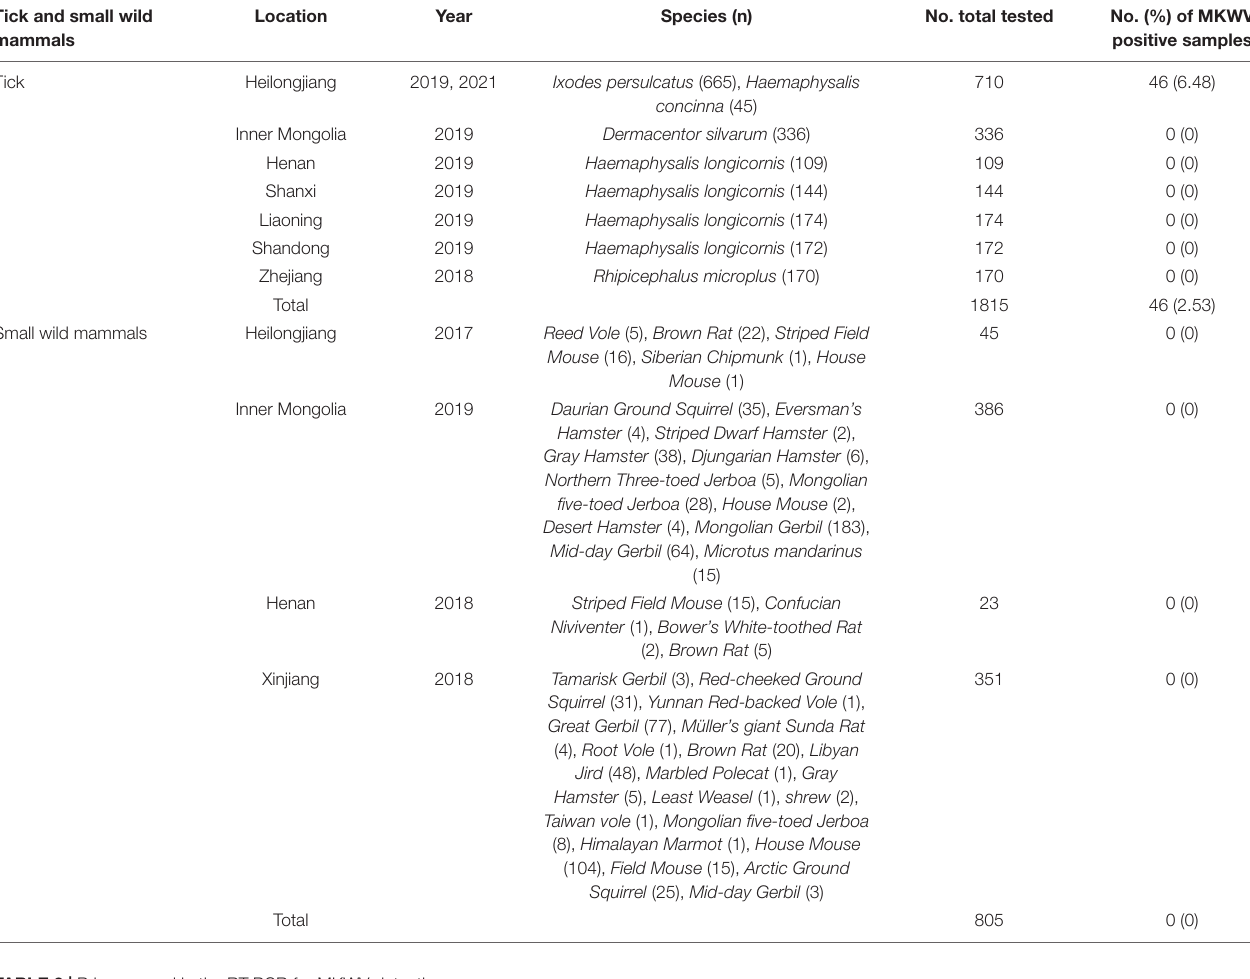
TABLE 1 | Tick and small wild mammals screened for MKWV. Tick and small wild mammals